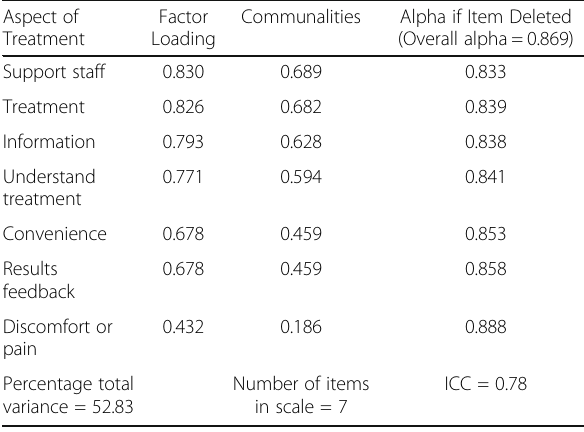
Table 9 AneurysmTSQ factor loadings, communalities and reliability coefficients: Pre and post-repair